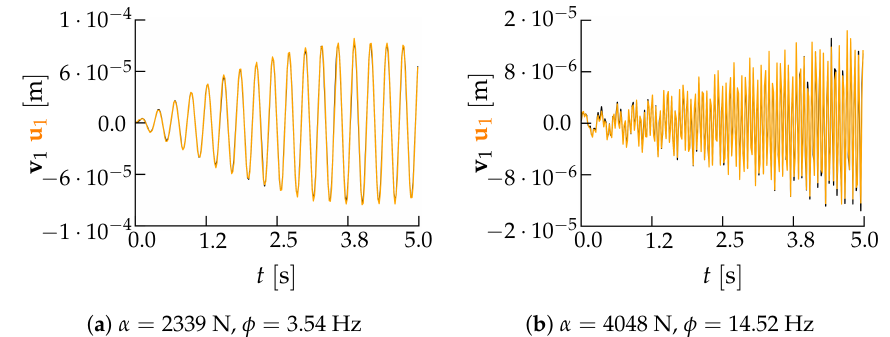
Figure 15. Two-storey shear building, configuration B, P = 6. Comparison between input (black) and reconstructed (orange) time histories of the first floor displacement for two cases belonging to the validation set and for load frequencies ( a ) φ ≈ f 1 and ( b ) φ ≈ f 2 .